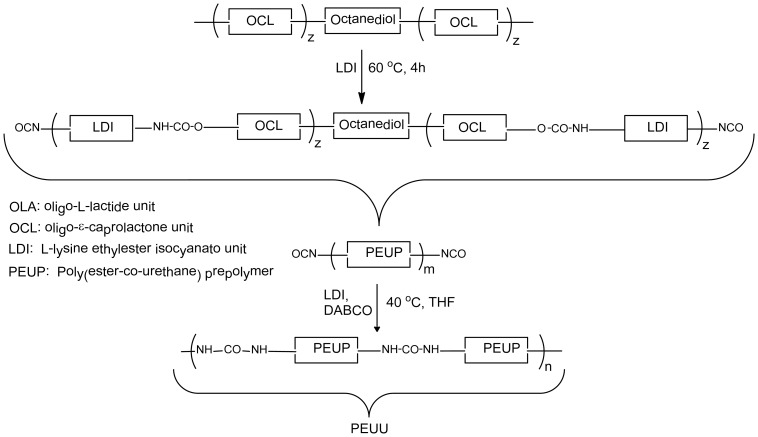
Schematic composition of copolymer PEUU.